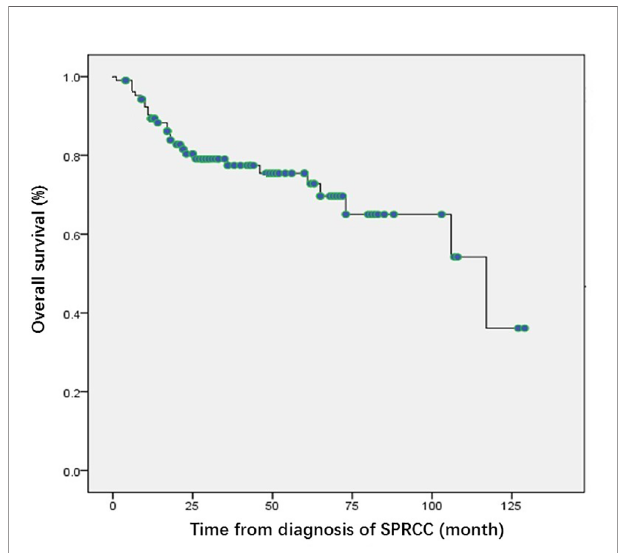
FIGURE 1 | Kaplan Meier curves of overall survival of the patients with second primary renal cell carcinoma. SPRCC, second primary renal cell carcinoma; OS, overall